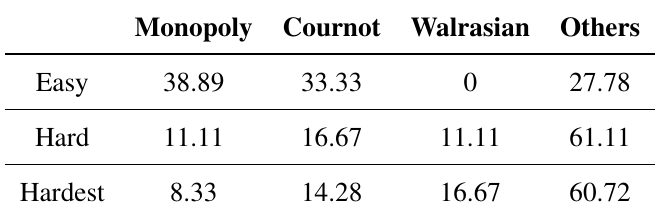
Table 6. Percentage of outputs corresponding to various market levels.